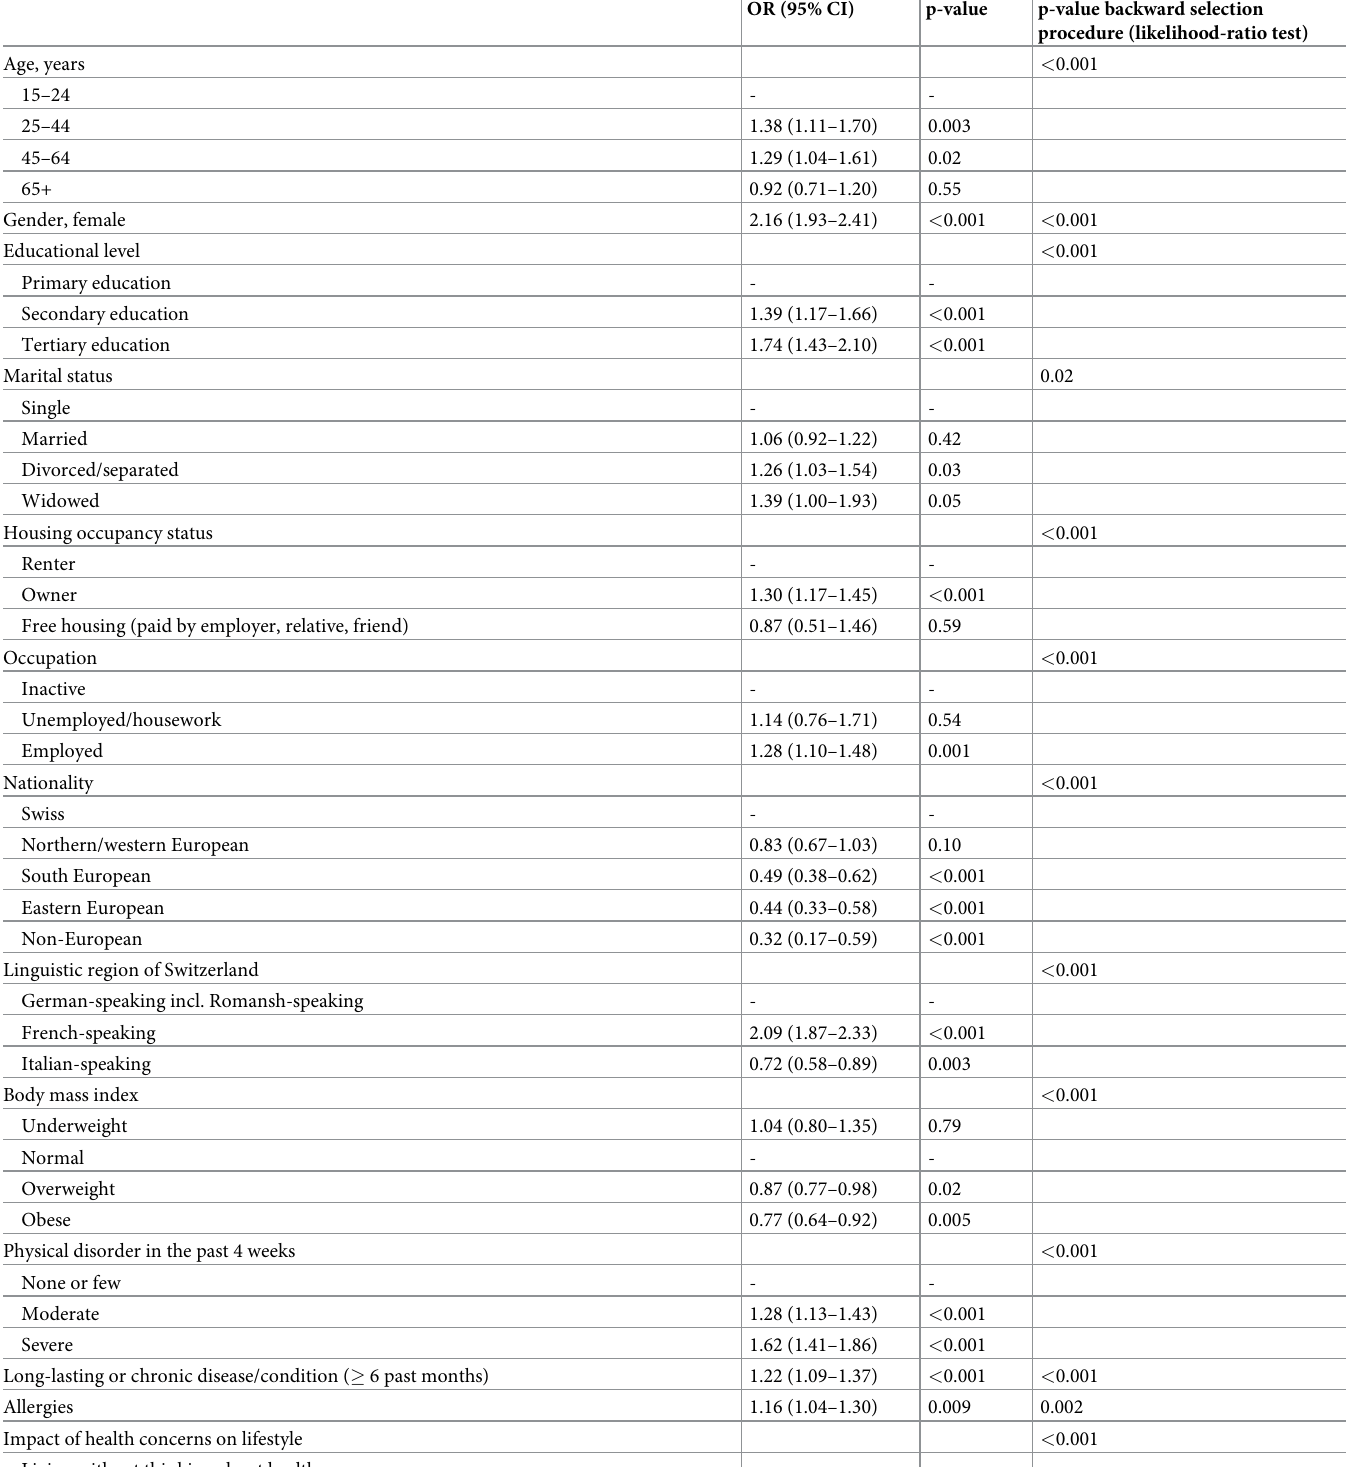
Table 7. Determinants of other CM therapies use using multivariate logistic